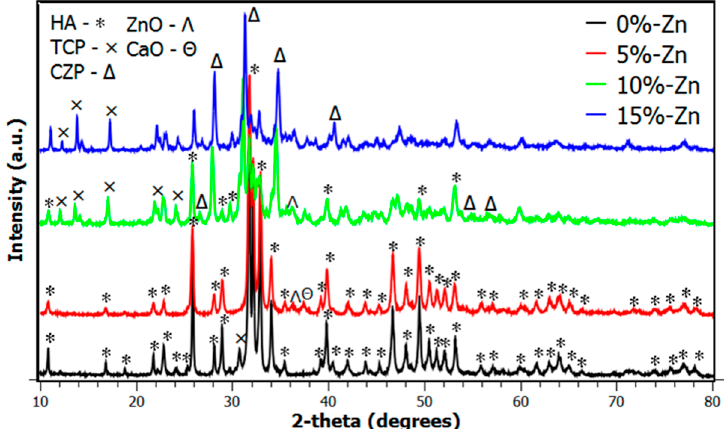
Figure 3. X-ray diffraction diagram of the Zn-doped HA cermet coatings showing the evolution of the calcium zinc phosphate phase as zinc ion concentration increases. Reproduced with permission from [13], Elsevier, 2018.